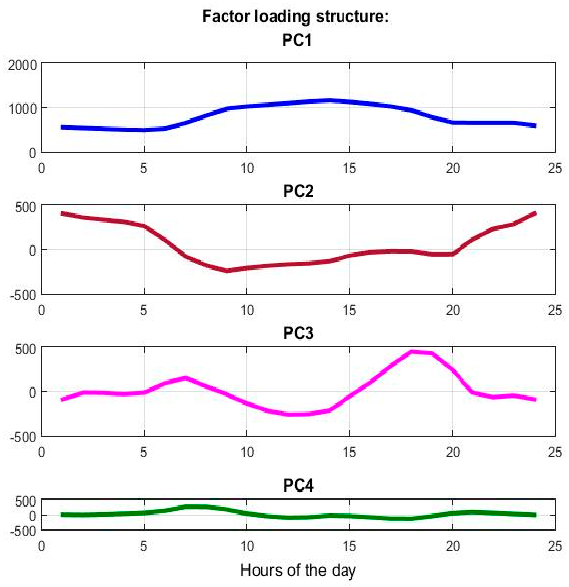
Figure 12. First four PCA coefficients (loadings). Energies 2016 , 9 , 635